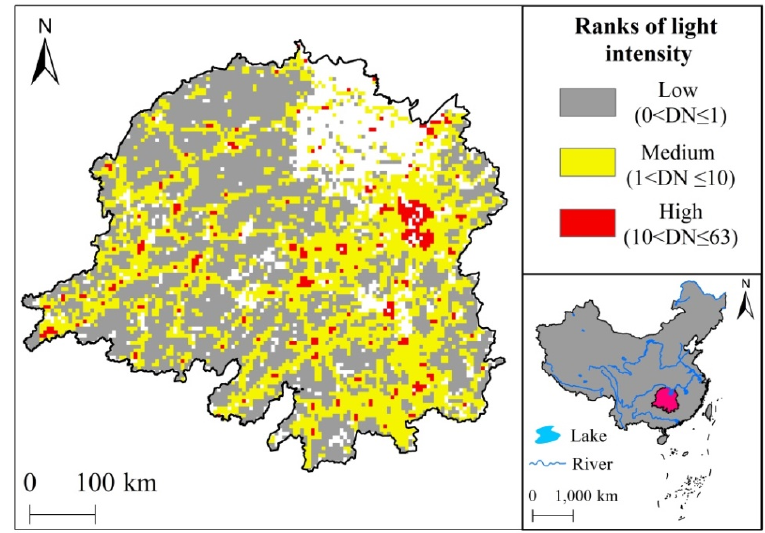
Figure 1. Classification of urbanization intensity in Dongting Lake